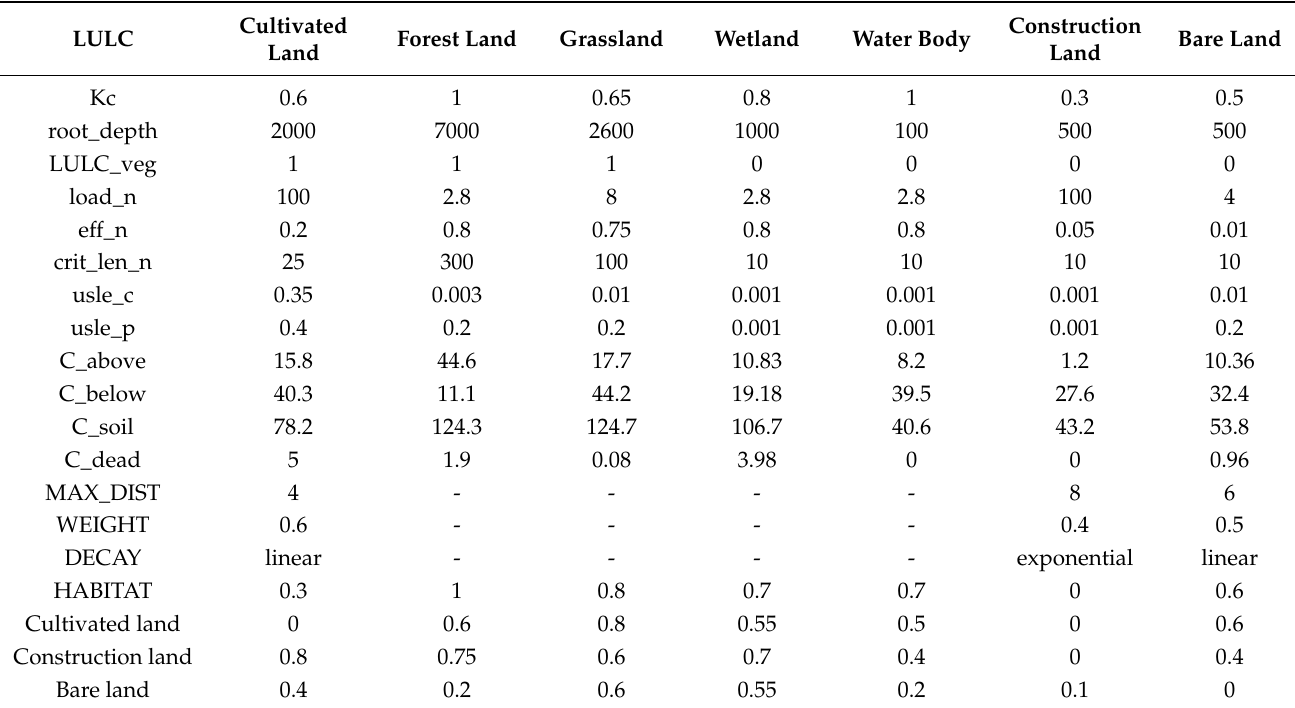
Table 1. Biophysical data used in the InVEST